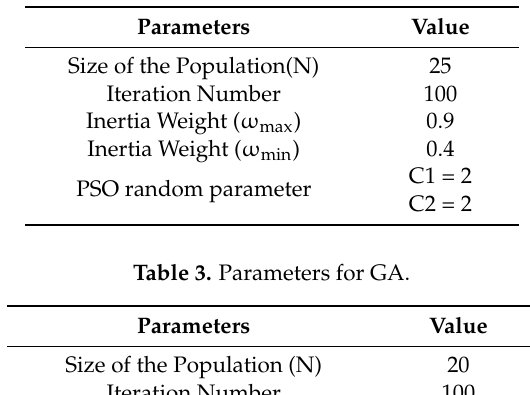
Table 2. Parameters for PSO.